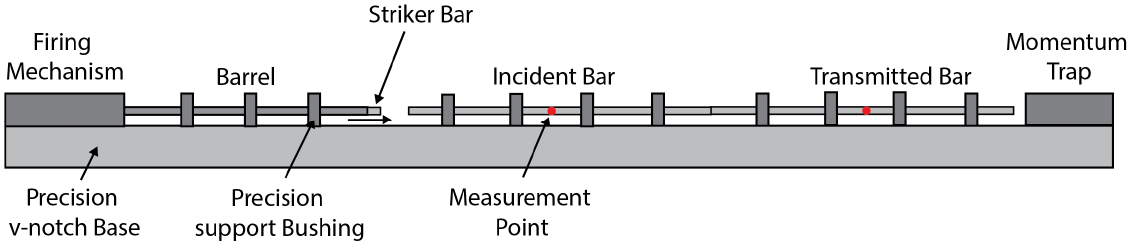
Figure 1. A general layout of the Split-Hopkinson Pressure Bar setup.